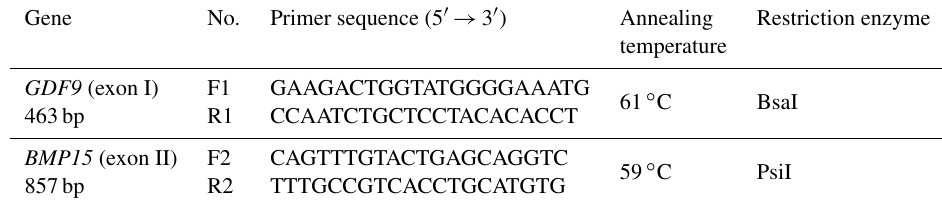
Table 1. Primers and PCR conditions of the genes and restriction enzymes. Gene No. Primer sequence (5 (cid:48) → 3 (cid:48) )